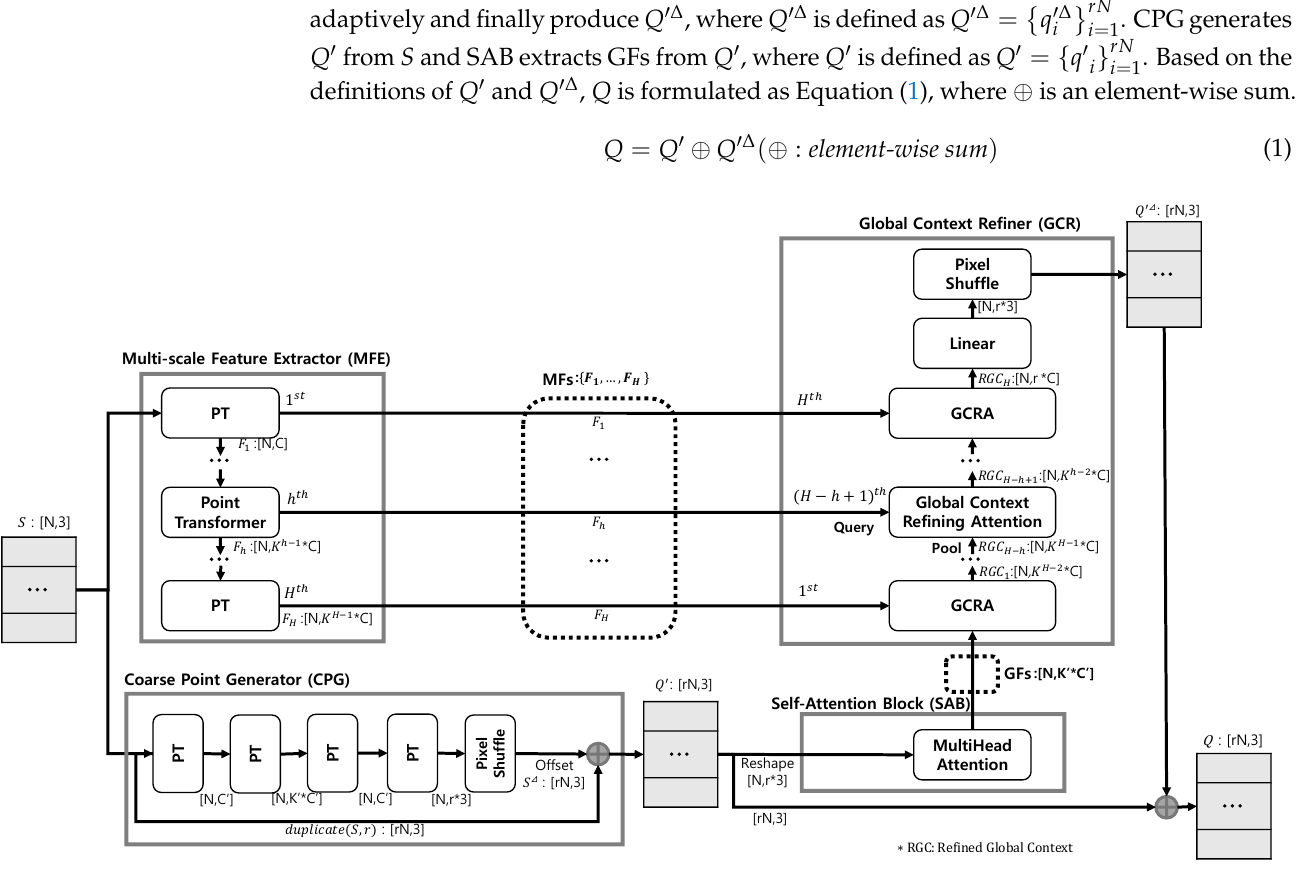
Figure 2. Illustration of the proposed framework. Here, 3 is the coordinate dimension, and H is the depth of the layer. In Multi-scale Feature Extractor (MFE) and Global Context Refiner (GCR), C is the channel, and K is the expansion ratio. In Coarse Point Generator (CPG) and Self-Attention Block (SAB), C (cid:48) is the channel and K (cid:48) is the expansion